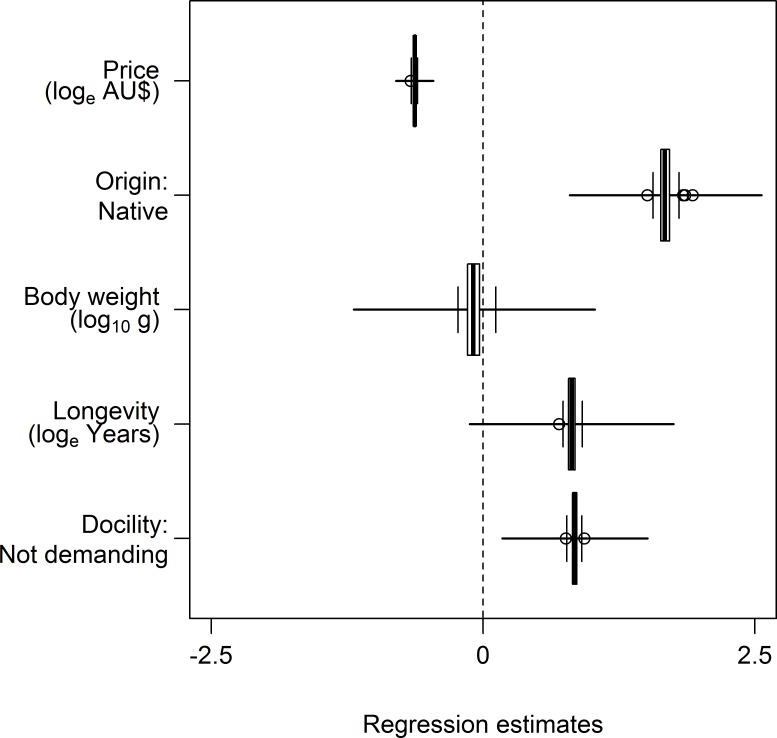
Coefficient plot for the model averaged phylogenetic logistic regression analyses for determinants of parrot escapes.Positive regression estimates represent higher frequency of introductions, and vice versa.